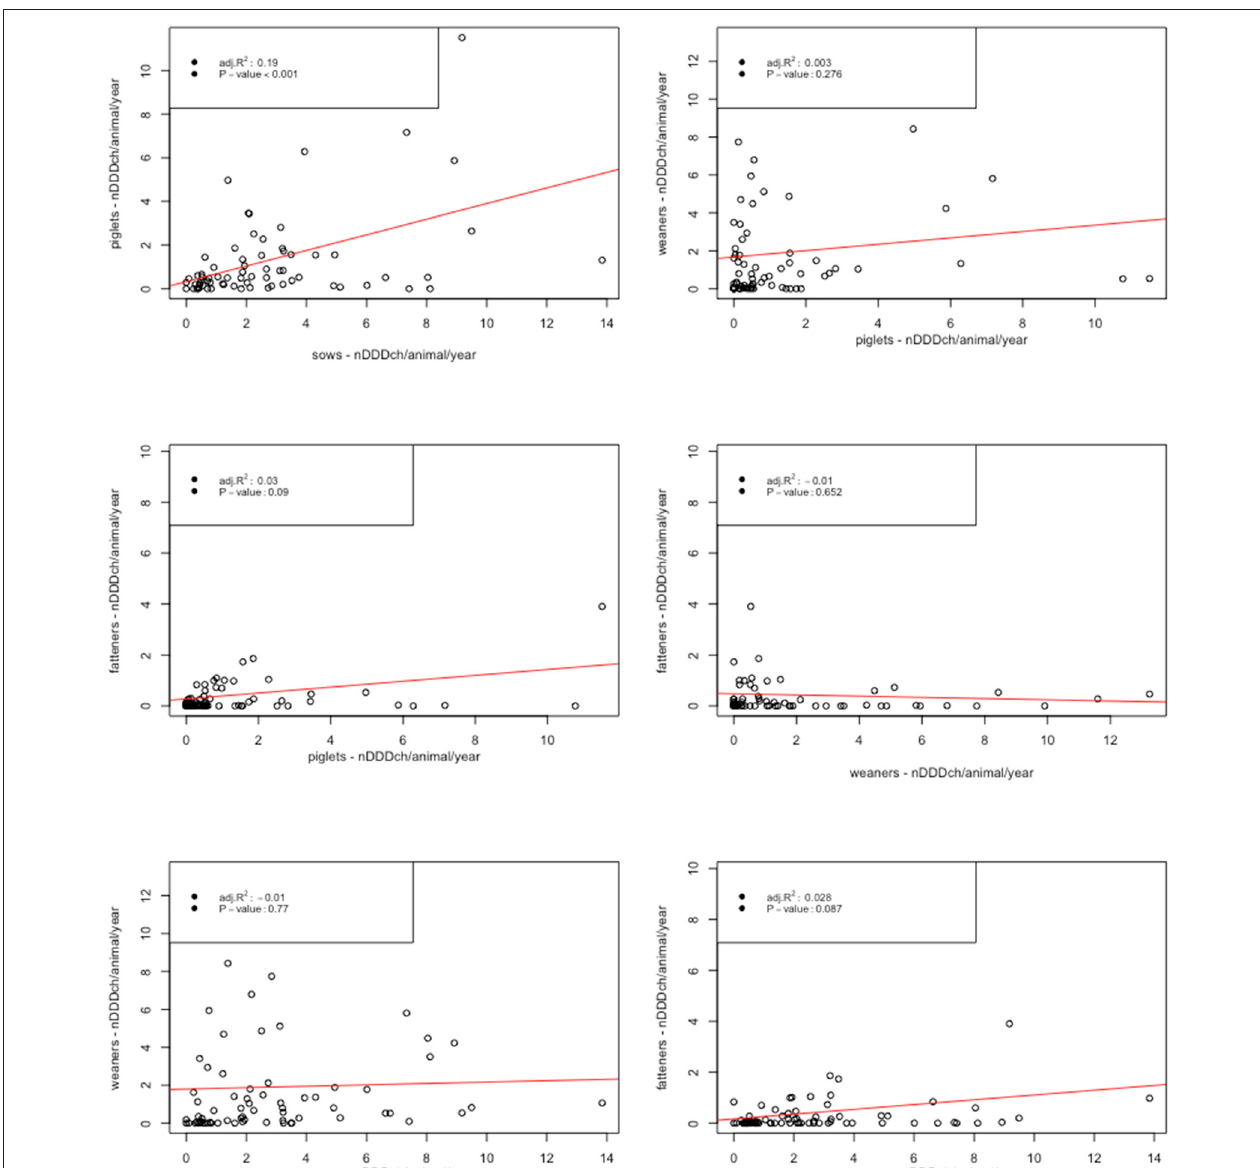
FIGURE 3 | Scatterplots and linear regressions for the within-herd relationship of the number of defined daily dose Switzerland per pig (nDDDch/animal/year) among the different age categories (piglets, weaners, fatteners, and sows) for 71 farrow-to-finish pig herds in Switzerland.